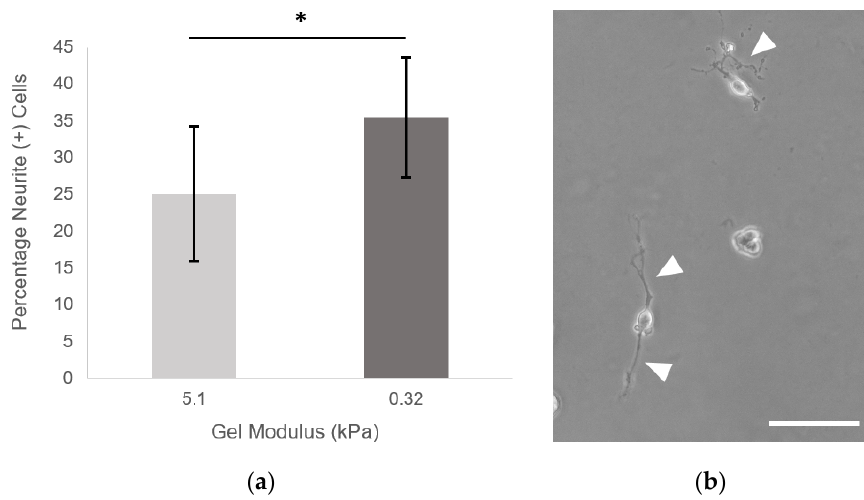
Figure 8. Neurite outgrowth is increased on softest hydrogels. ( a ) PC-12 neurite outgrowth as a function of gel modulus. Neurite (+) cell = has at least one neurite ≥ 2× the cell body diameter. Data shown as mean ± S.D. * p < 0.05, indicating a statistically significant difference. Statistical analysis evaluated by Student’s t -test, n = 9 gels; ( b ) PC-12 cells on 0.32 ± 0.09 kPa gels at day 7. Arrowheads indicate neurites. Scale bar = 100 µm.